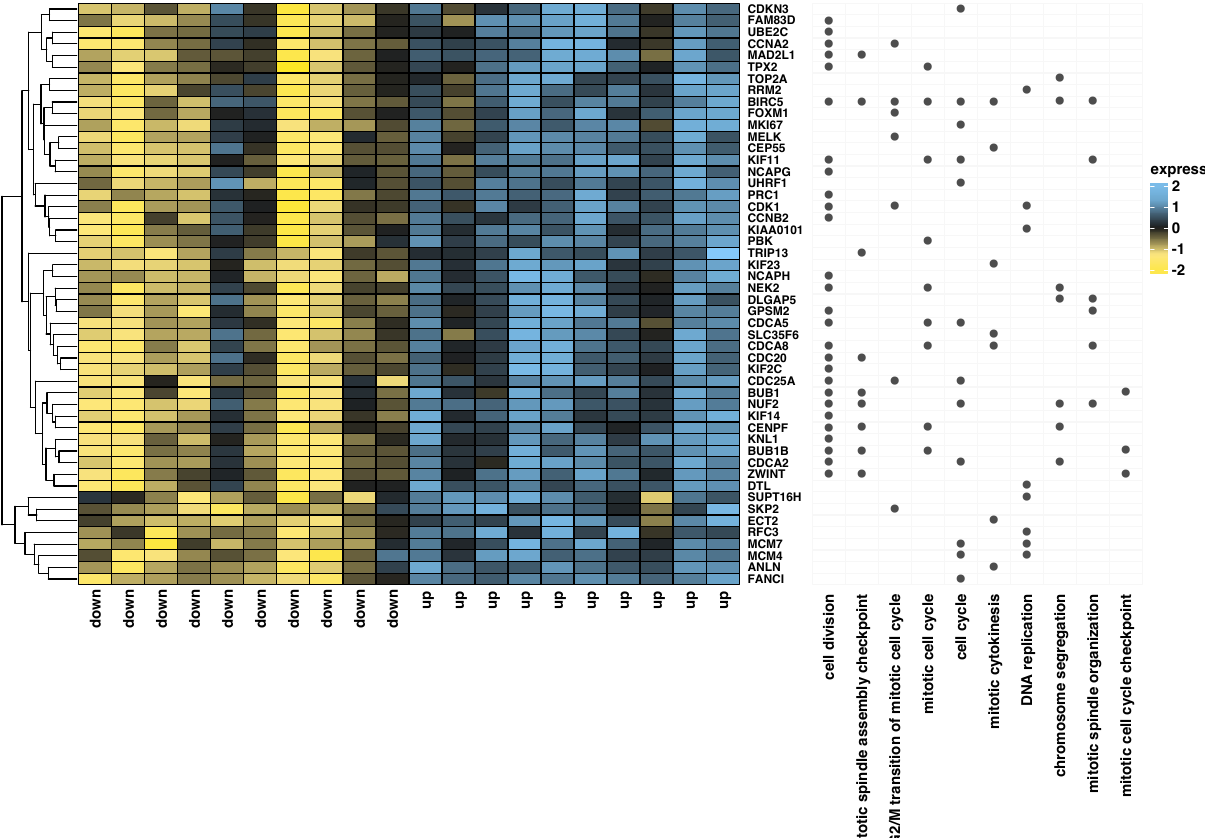
Figure 7. Heatmap of differentially expressed genes in the patients with adrenocortical carcinoma with the highest (up) and the lowest (down) expression of the ZWILCH gene. The heatmap on the right side displays the ten most significantly enriched ontological groups (with the lowest adjusted p − value), represented by dark dots. Expression values are scaled by rows and presented as color ranges from yellow (low expression) to blue (high